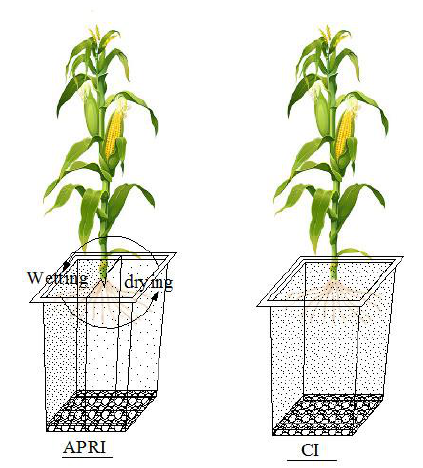
Figure 2. Layout of the two irrigation methods.